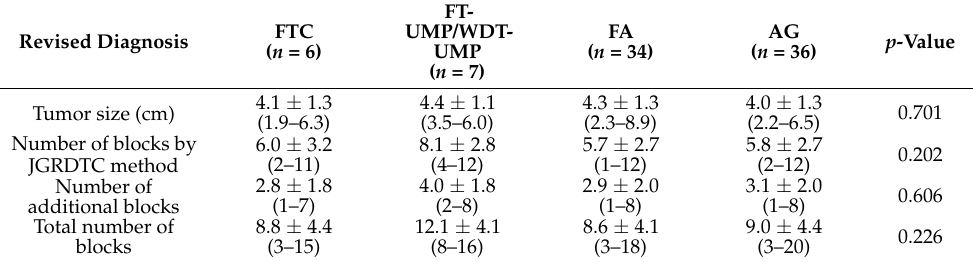
Table 4. Tumor size by type and the number of tissue blocks assessed in each revised diagnosis. Revised Diagnosis